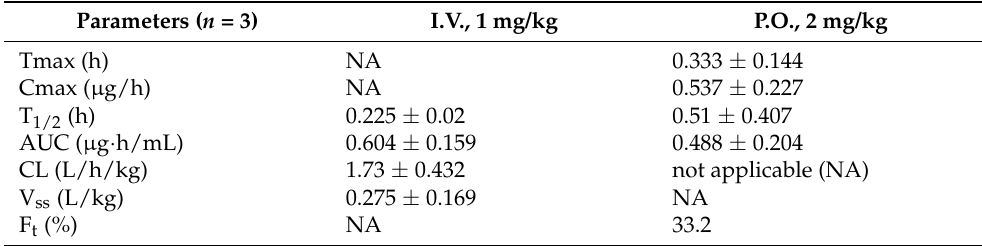
Figure 4. Effects of cardiotonic steroids on 5-day repeated dose toxicity. Survival rate ( A ) and body weight changes ( B ) of mice with intraperitoneal injection of digitoxin, cinobufagin, cinobufotalin, telocinobufagin, bufalin, or bufotalin at a daily dose of 10 mg/kg/day (five mice/group) for 5 days. Table 2. Rat pharmacokinetic study of